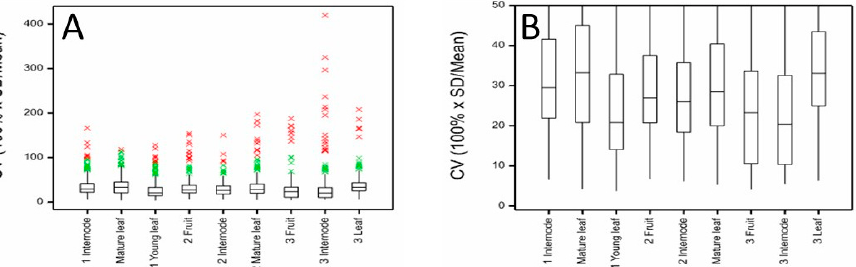
Figure 2. Distribution of coefficients of variation (CV) for metabolites measured by LC-MS in internode, mature and young leaf, and fruit of ‘Hayward’ kiwifruit samples showing ( A ) the full range of values and ( B ) the interquartile ranges. The boxes cover the middle 50% of measurements; 25% are below the bottom of the box and 25% are above. The whiskers cover no more than 1.5 × height of box above the top or below the bottom of the box. Beyond that, individual observations are shown in green (1.5× height of box to 3 × height of box) or red (more than 3× height of box beyond the box).